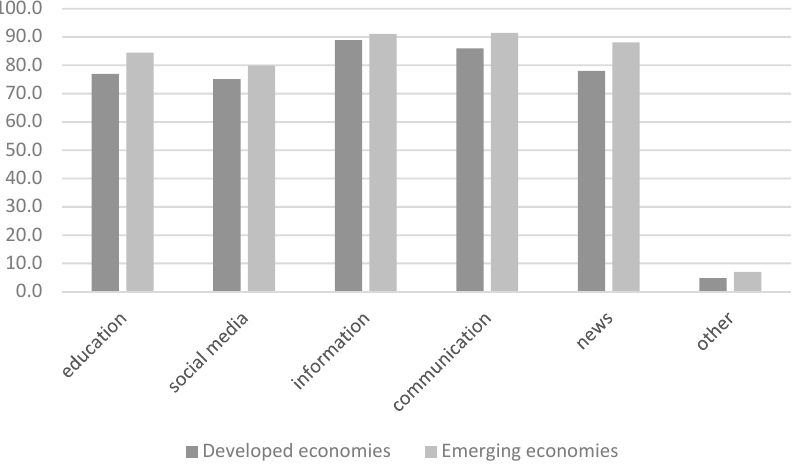
Figure 7. Awareness of technology benefits in different fields .